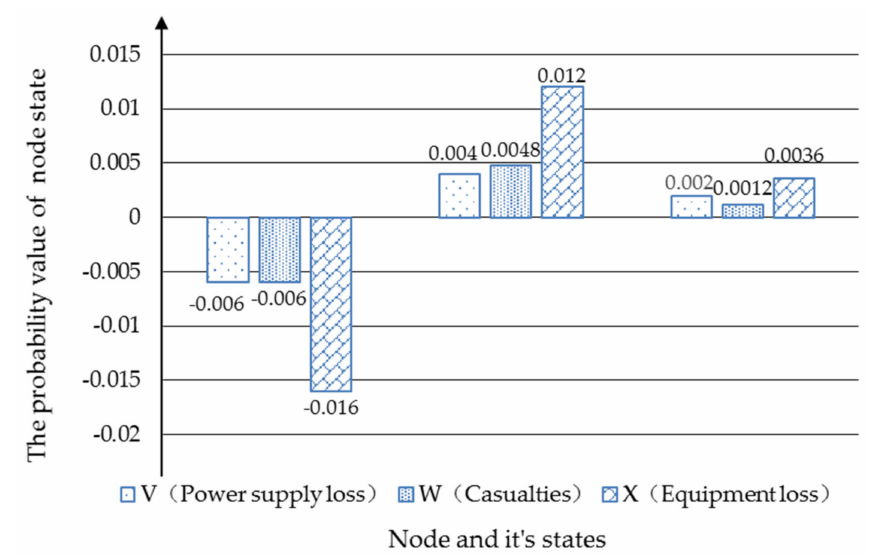
Figure 12. The probabilities change before and after “Power supply loss”, “Casualties” and “Equipment